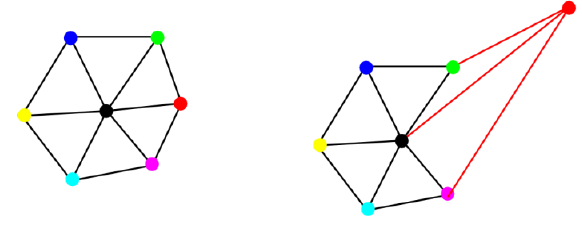
Figure 4. An erroneous 2D point and the resultant triangulation are displayed.